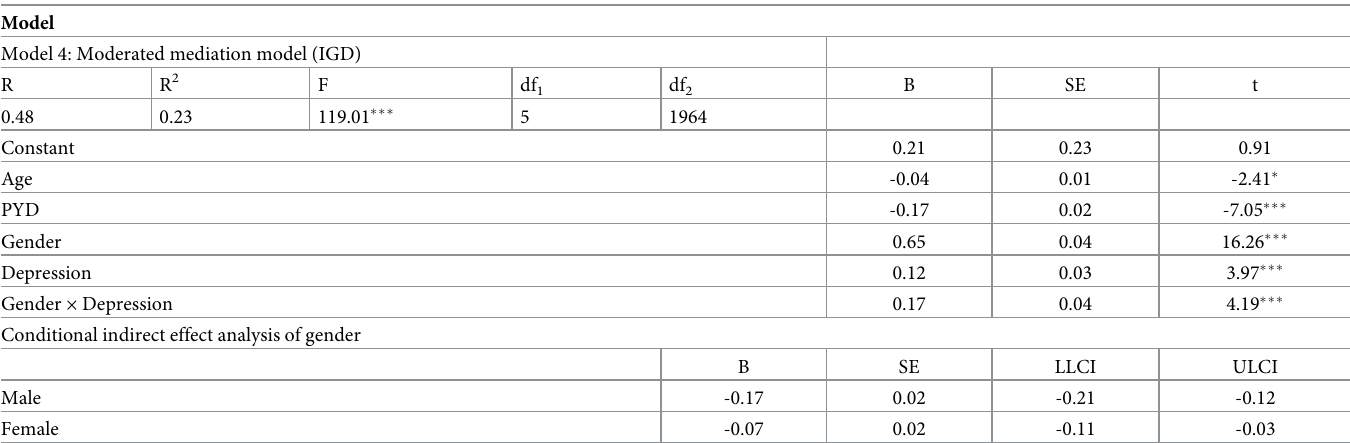
Table 3. Regression results for the moderated mediation model.